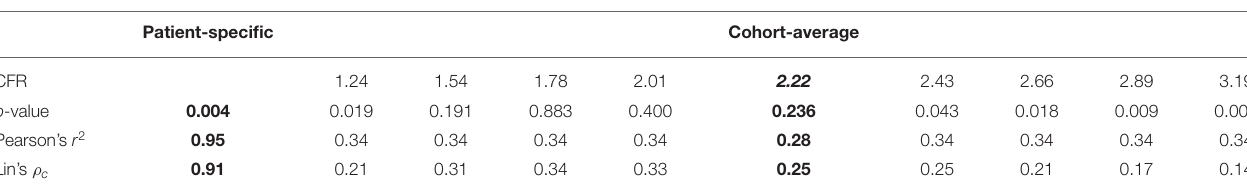
TABLE 1 | Statistical results for all simulated CFR